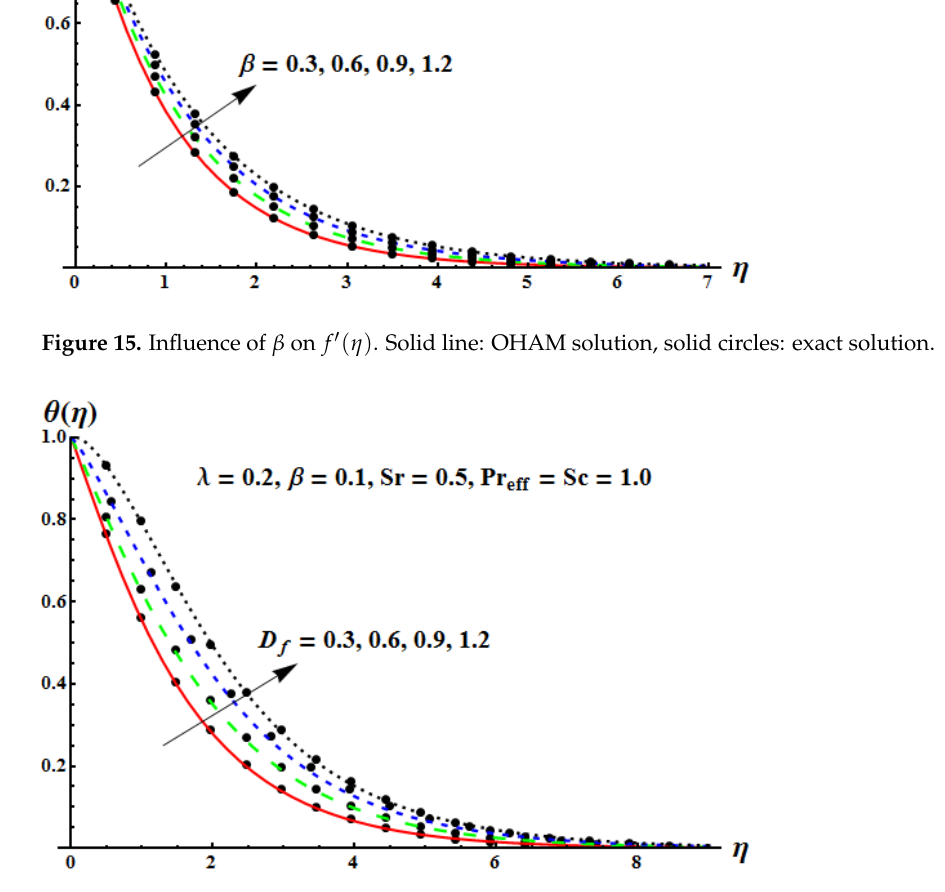
Figure 16. Influence of D f on θ ( η ) . Solid line: OHAM solution, solid circles: numerical solution.